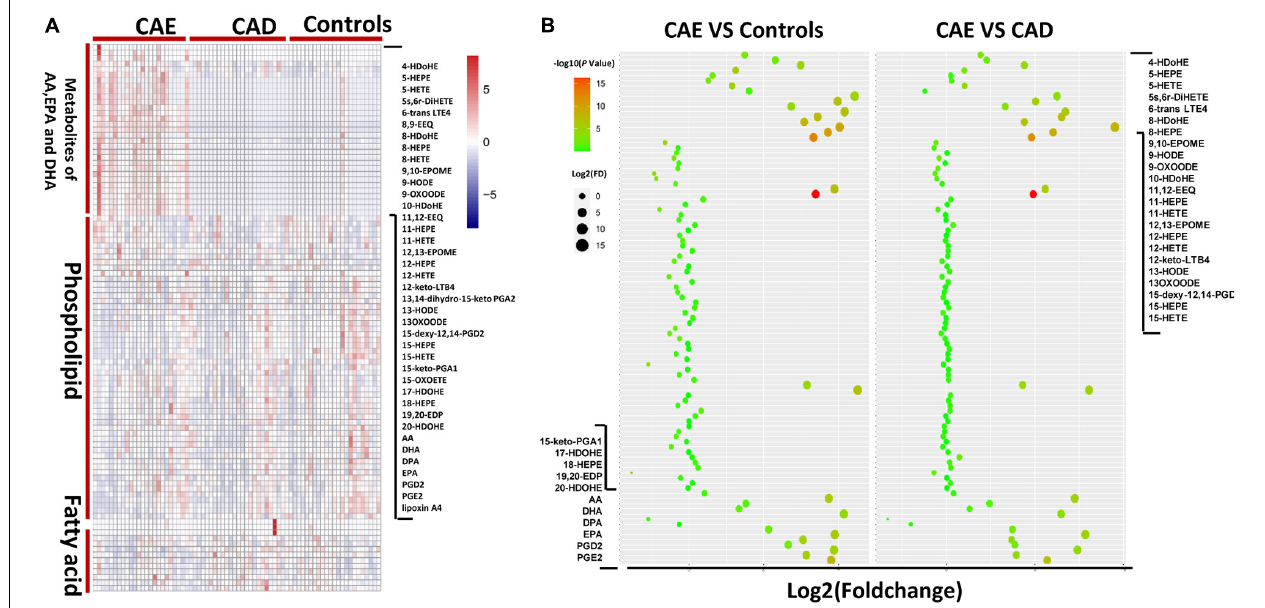
FIGURE 2 | Metabolic profiles of lipids in plasma from different subjects. (A) Comparison of 99 plasma metabolites concentrations in 72 discovery sets. (B) Fold change of 99 plasma metabolites in 72 discovery